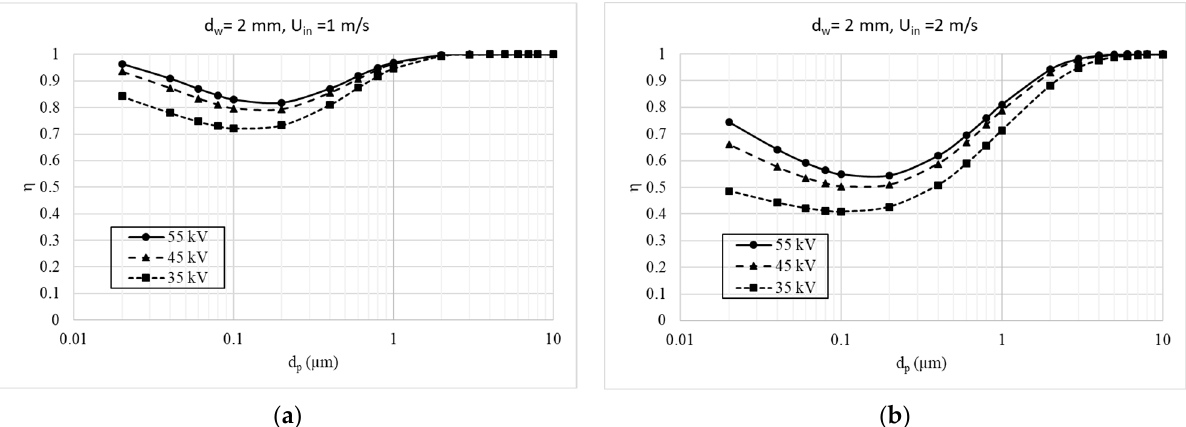
Figure 17. Variation of the ESP collection efficiency with particle diameter for S y = 90 mm, d w = 2 mm, ( a ) U in = 1 m/s, ( b ) U in = 2 m/s.